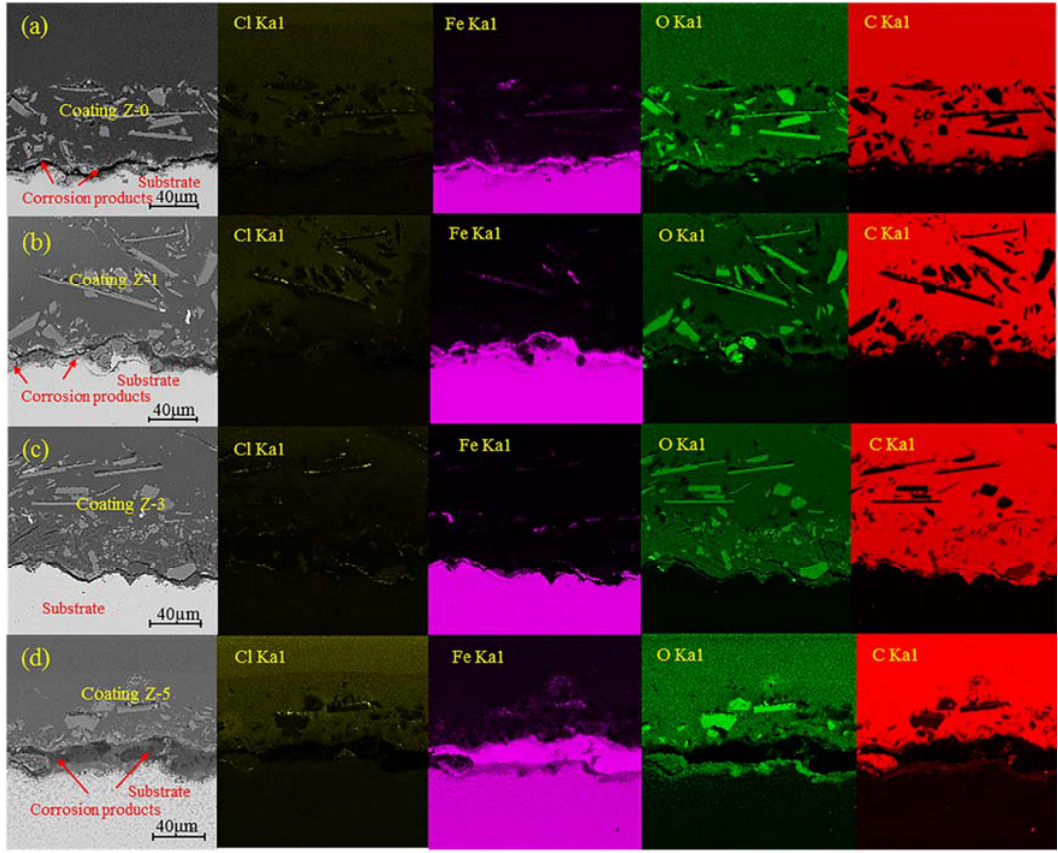
Figure 4. The cross section morphology and chemical element mapping of different nano-ZrO 2 -modified coatings after 192 h of acid immersion: Z-0 coating ( a ), Z-1 coating ( b ), Z-3 coating ( c ), and Z-5 coating ( d ).